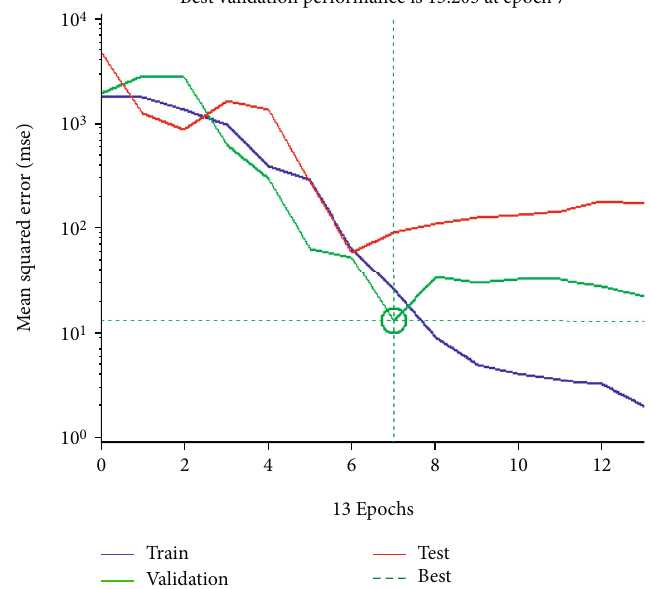
Figure 11: Performance plot for CEX onto Fe